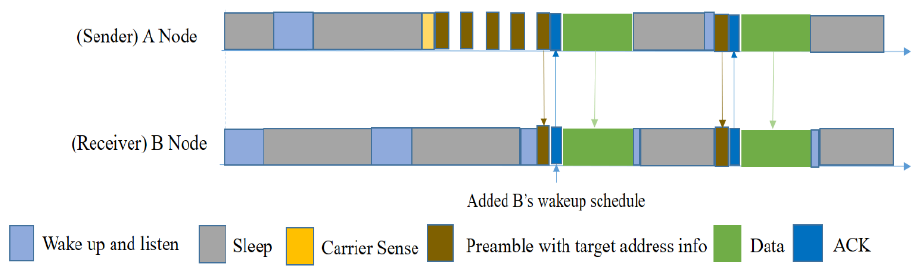
Figure 13. Packet transmission in RIX-MAC [36].